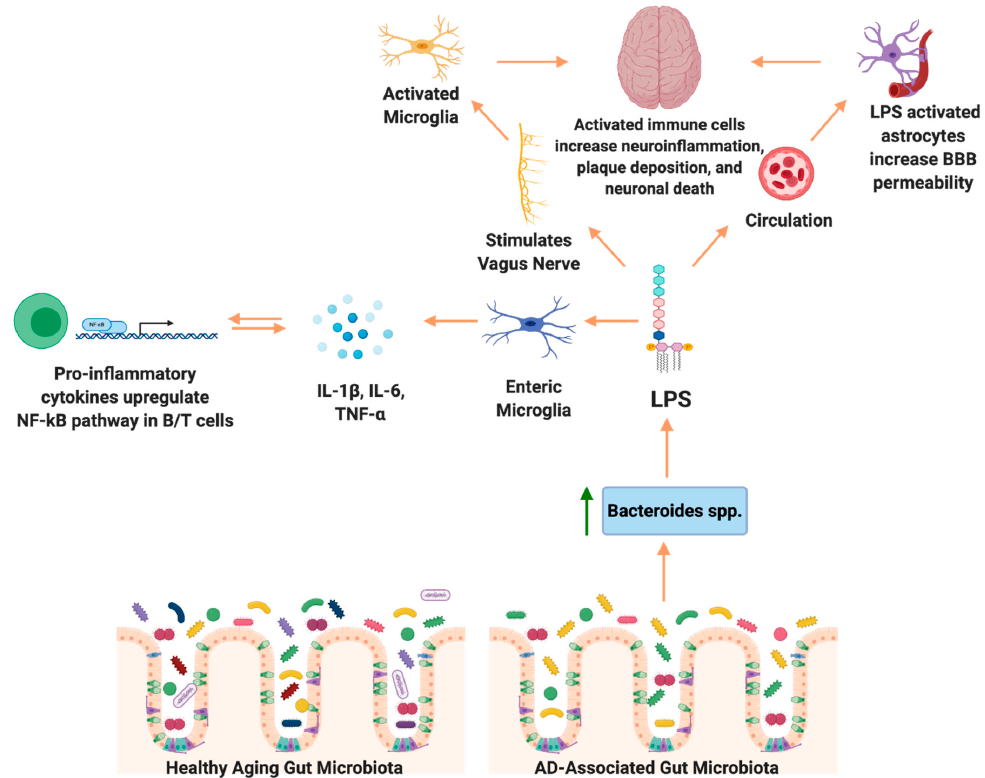
Figure 1. Proposed mechanism of lipopolysaccharide (LPS)-induced neuropathologies in Alzheimer’s disease (AD). AD-associated microbiome composition has increased abundance of lipopolysaccharide (LPS) producing bacteria, including Bacteroides . LPS stimulates enteric microglia to produce Interleukin (IL)-1 β , IL-6, and Tumor necrosis factor (TNF)- α , which induces the nuclear factor kappa-B (NF- κ B) pathway, therefore upregulating expression of proinflammatory cytokines. Similarly, LPS stimulates the vagus nerve, activating microglia in the brain, thereby promoting neuroinflammation. LPS is able to translocate from the gastrointestinal tract to the circulatory system and stimulate astrocytes. The reduction in blood brain barrier (BBB) integrity allows LPS to cross the BBB and further promote inflammation in the brain.